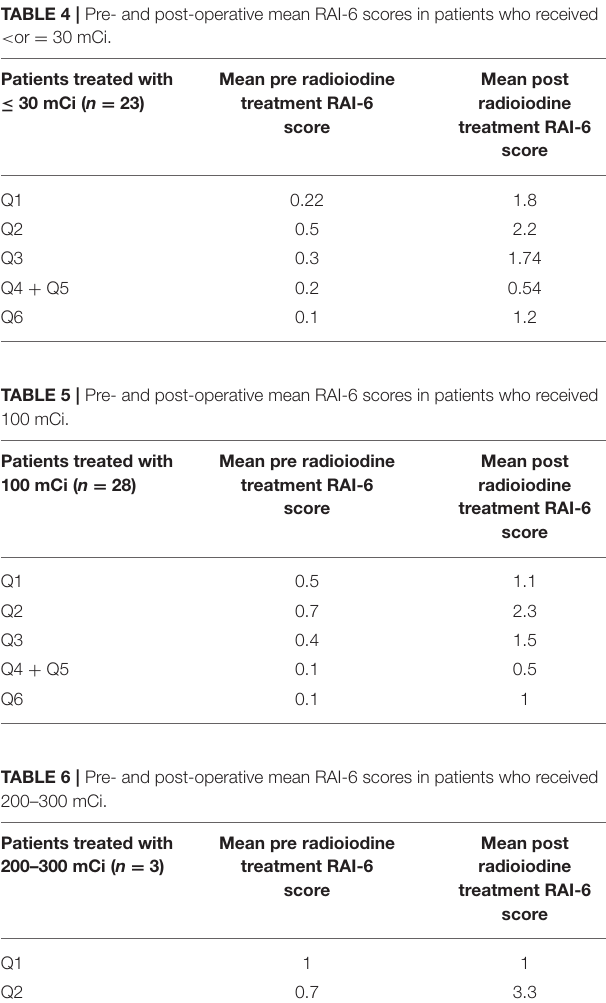
treatment and this difference also increased with the radioiodine dose. Our results correlate with Dingle et al.who determined the prevalence of sialadenitis in patients treated with radioiodine